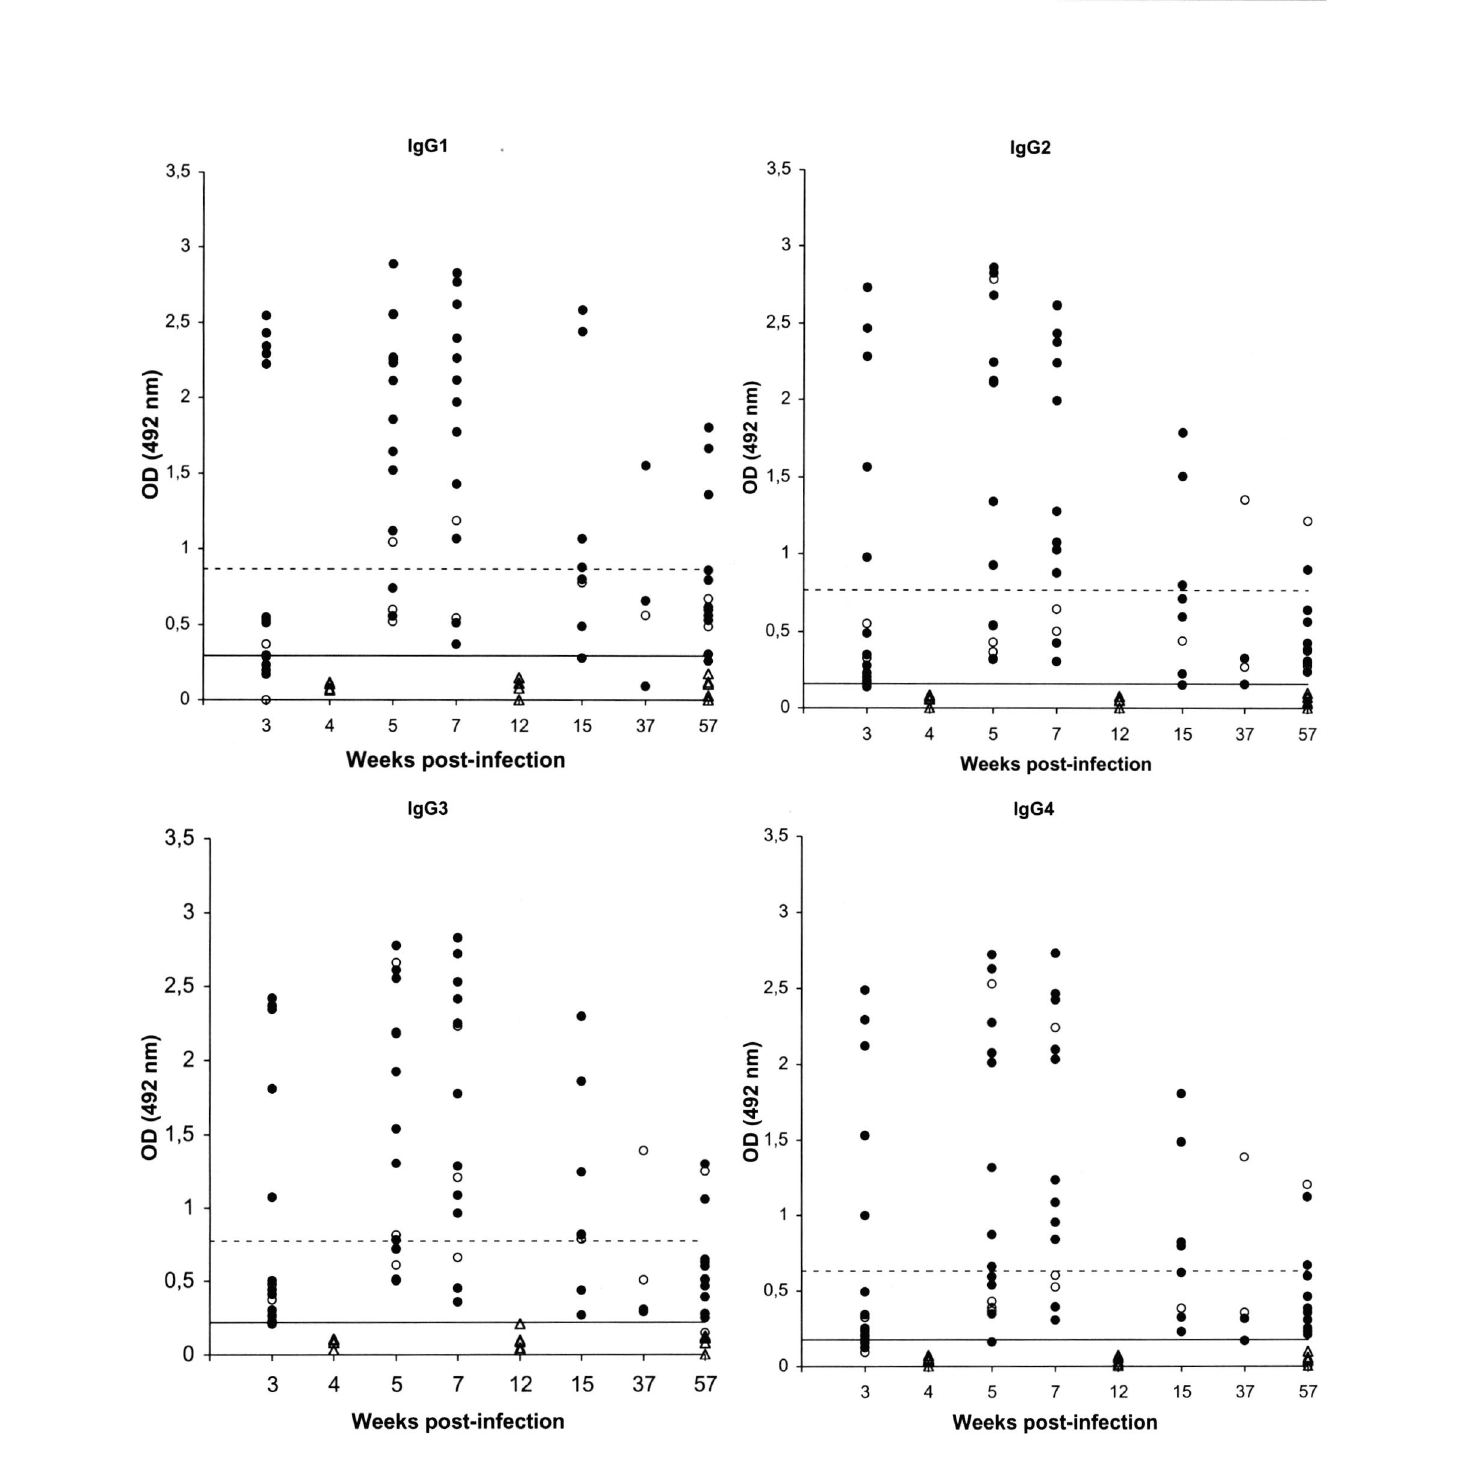
Fig. 2. Analysis by ELISA of subclass antibody response against the adult stage of Trichinella spiralis in trichinellosis patients during the infection. Ia-ELISA assays were carried out to detect IgA and IgE antibodies as described in material and methods. Serum samples from symptomatic trichinellosis patients with: • positive or O negative biopsy and from V asymptomatic individuals, were analyzed. Doted line: cut-off value (media + 3σ from patients with other parasitosis). Line: cut-off value from healthy individuals.